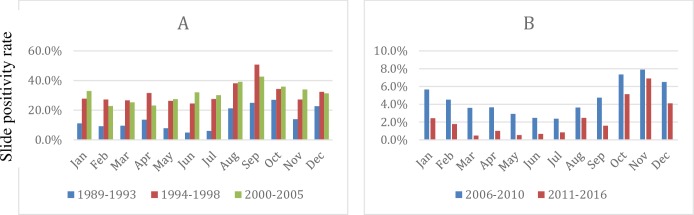
Temporally aggregated monthly SPR showing shifted peaks of malaria transmission from A) September during the pre-intervention period (1989–2005) to B) November in the post-intervention period (2006–2016).